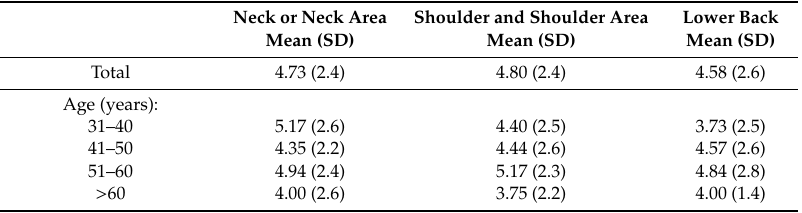
Table 1. The severity of discomfort / pain in the neck and / or neck area, the shoulder and / or shoulder area, and the lower back on a scale of 1–10 in the past six